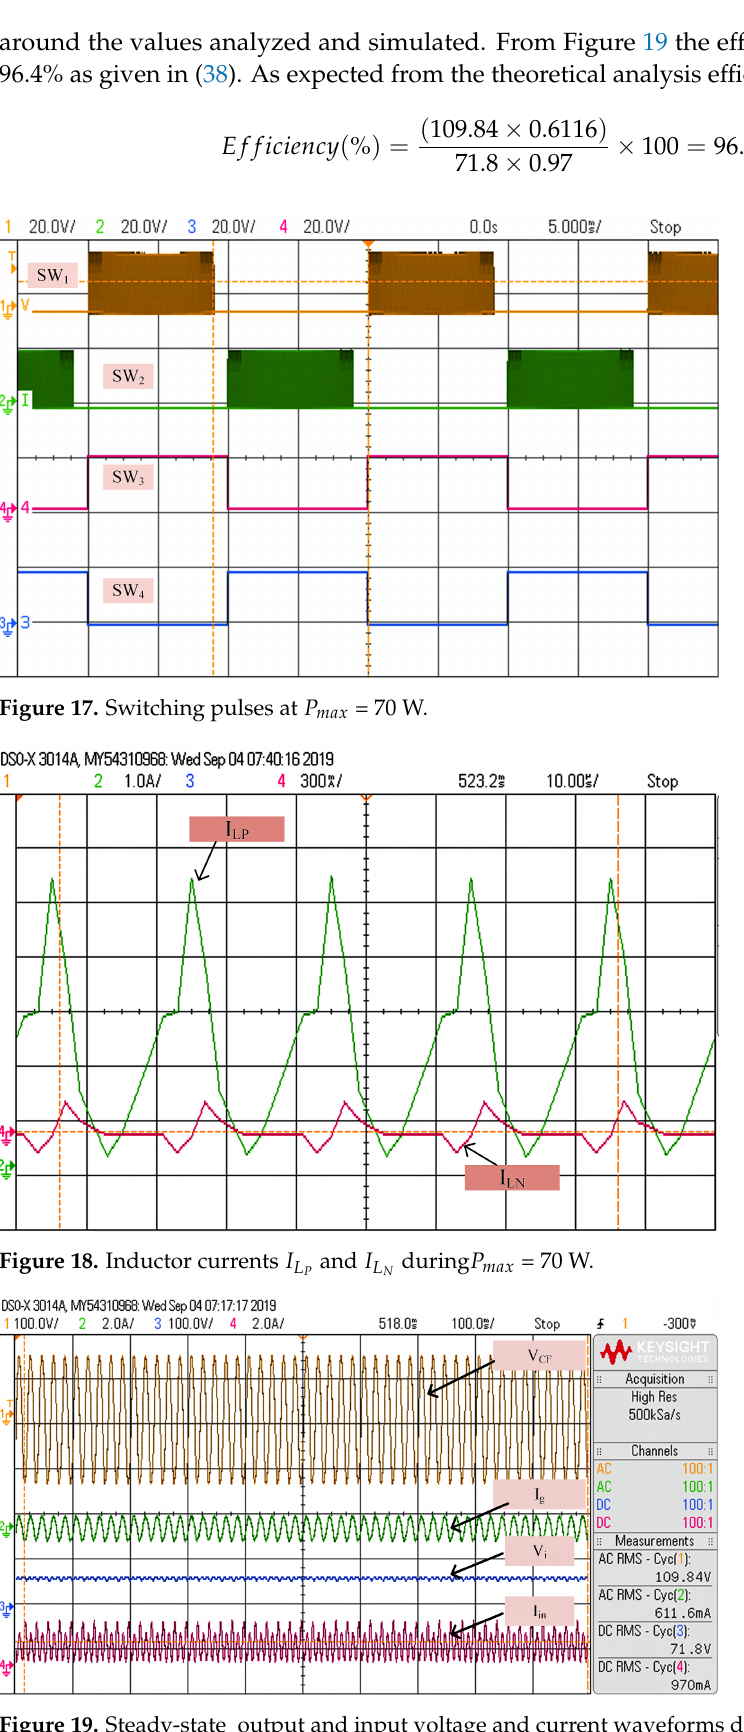
Figure 19. Steady-state output and input voltage and current waveforms during P max = 70